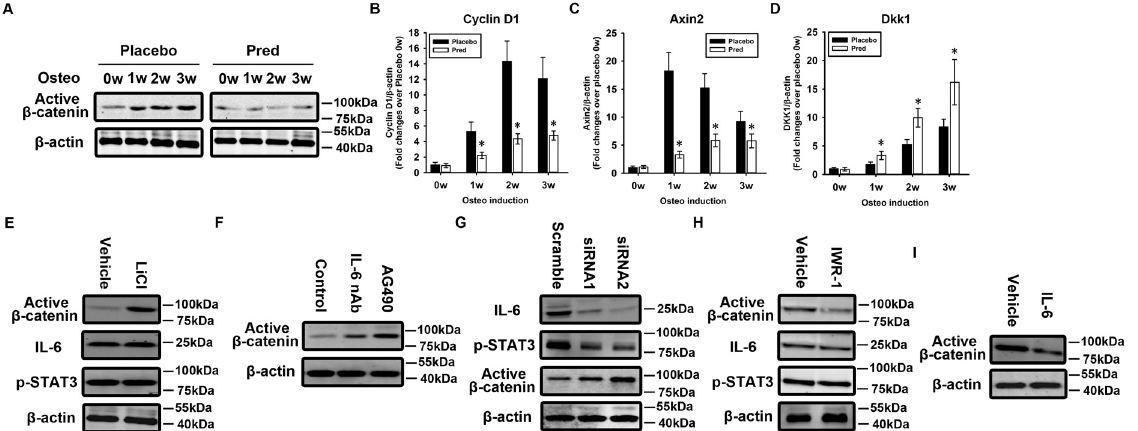
Fig 6. Over-activation of IL-6-STAT3 signaling inhibits β -catenin activity. Normal and osteoporotic BMSCs were induced to undergo osteogenesis. Zero, 1, 2, and 3 weeks after induction, total protein was harvested, and western blotting was carried out using an antibody against non-phospho (active) β -catenin (A) . Total RNA was harvested, and quantitative RT-PCR was carried out using primers for cyclin D1 (B) , Axin2 (C), and Dkk1 (D) . The results are expressed as the fold-change relative to normal BMSCs without induction. The data are shown as the mean ± SD. Osteoporotic BMSCs were treated with LiCl to activate β -catenin (E) . An IL-6 neutralizing antibody and AG490 were used to block IL-6-STAT3 signaling (F) . shRNAs were used to silence IL-6 expression (G) . Normal BMSCs were treated with IWR-1 to inhibit β -catenin (H) . Total protein was harvested, and western blotting was carried out using antibodies against active β -catenin, IL-6, and pSTAT3. IL-6 was added to the medium (I) . Western blotting was performed using an antibody against active β -catenin. β -actin was used as an internal control. * : p < 0.05, Pred vs . scrambled